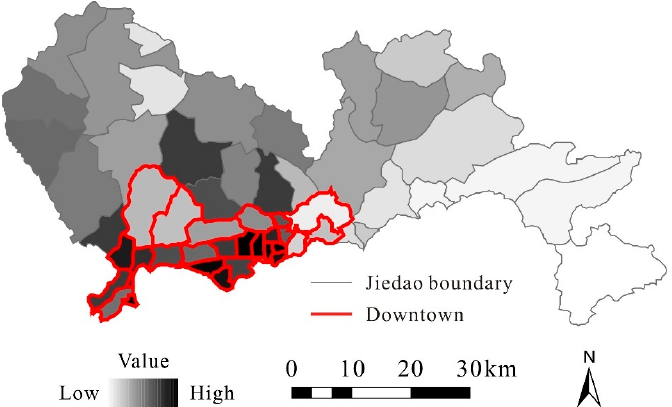
Figure 4 . Daily average accumulated population density at the township level. Figure 4. Daily average accumulated population density at the township level.